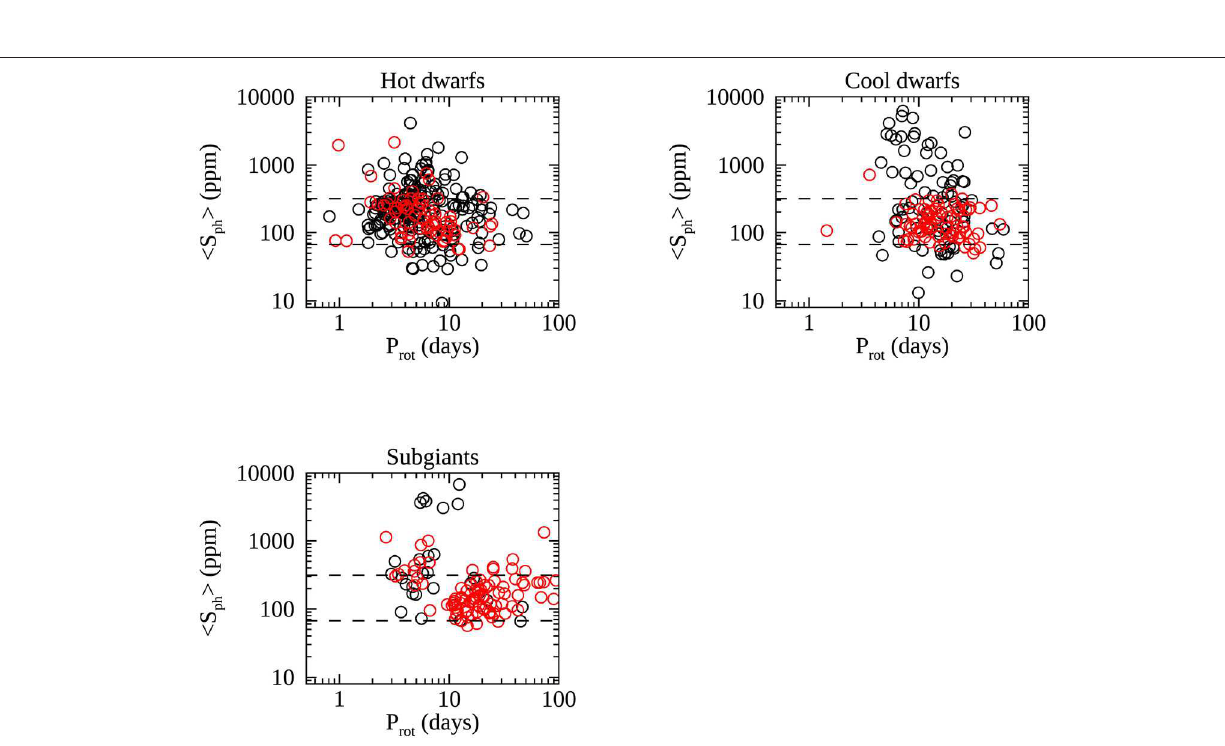
Frontiers in Astronomy and Space Sciences |